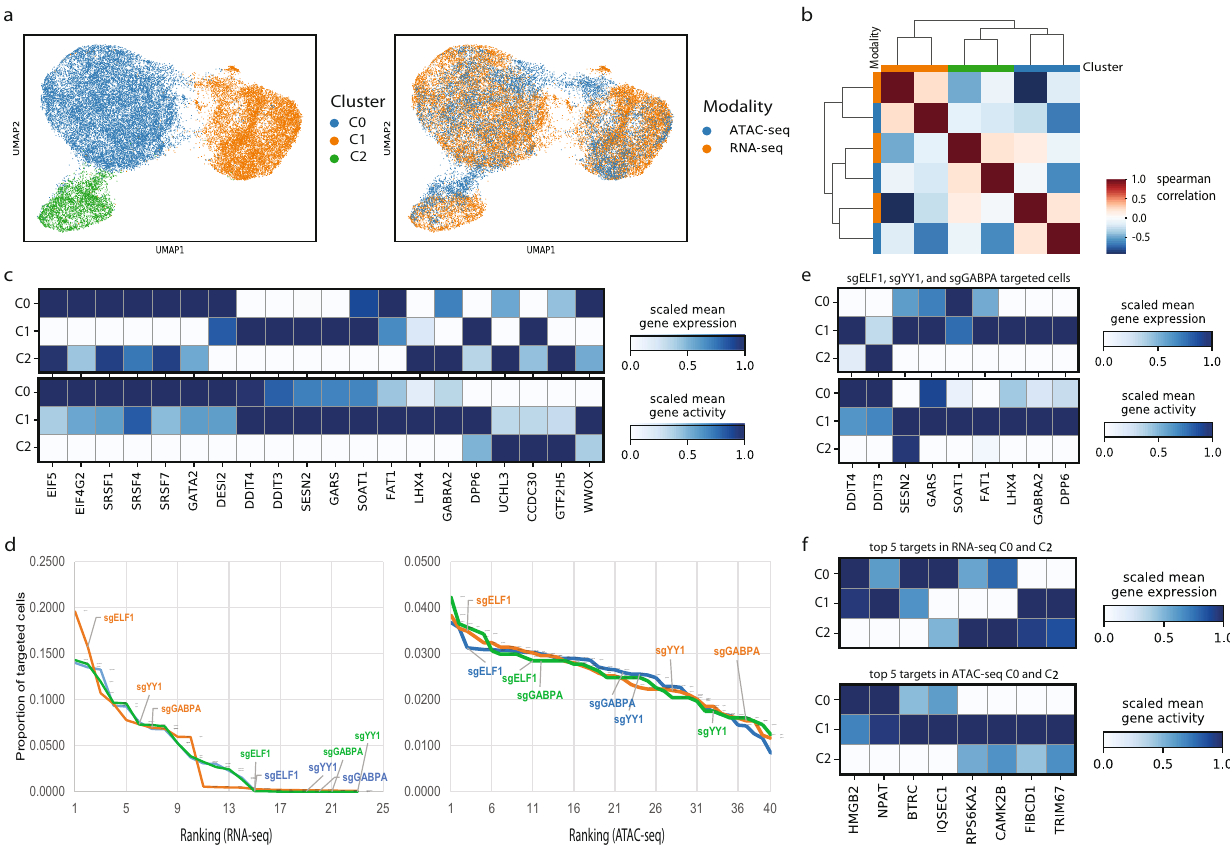
Fig. 4 sciCAN identi fi es common response after CRISPR perturbation. a Visualization of single-cell CRISPR-perturbed K562 RNA-seq and ATAC-seq data via UMAP. Cells are colored by identi fi ed cell clusters (left) and modality source (right). b Spearman correlation between RNA- seq and ATAC-seq pro fi les of cells in different clusters in both modalities. Gene expression or gene activity matrix was averaged by cell clusters. c Shared gene signatures of the 3 cell clusters in both modalities. Differential gene activities or expression were identi fi ed through ‘ Wilcoxon ’ test in Scanpy package. d Ranking of sgRNA representation in each cluster (blue = C0, orange = C1, green = C2) in both RNA-seq (left) and ATAC-seq (right) data. Genes perturbed in both experiments are highlighted. e Gene signatures of cells targeted by sgELE1 , sgYY1 , and sgGABPA in cell cluster 1. f Genes whose activity patterns distinguish cells in cluster 0 and cluster 2 among cells in these clusters perturbed by the same